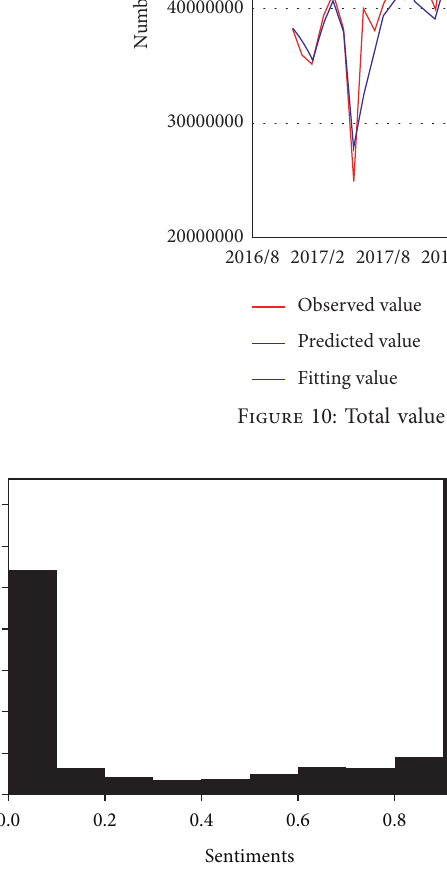
Figure 11: Polarity of the popular support in the US election.